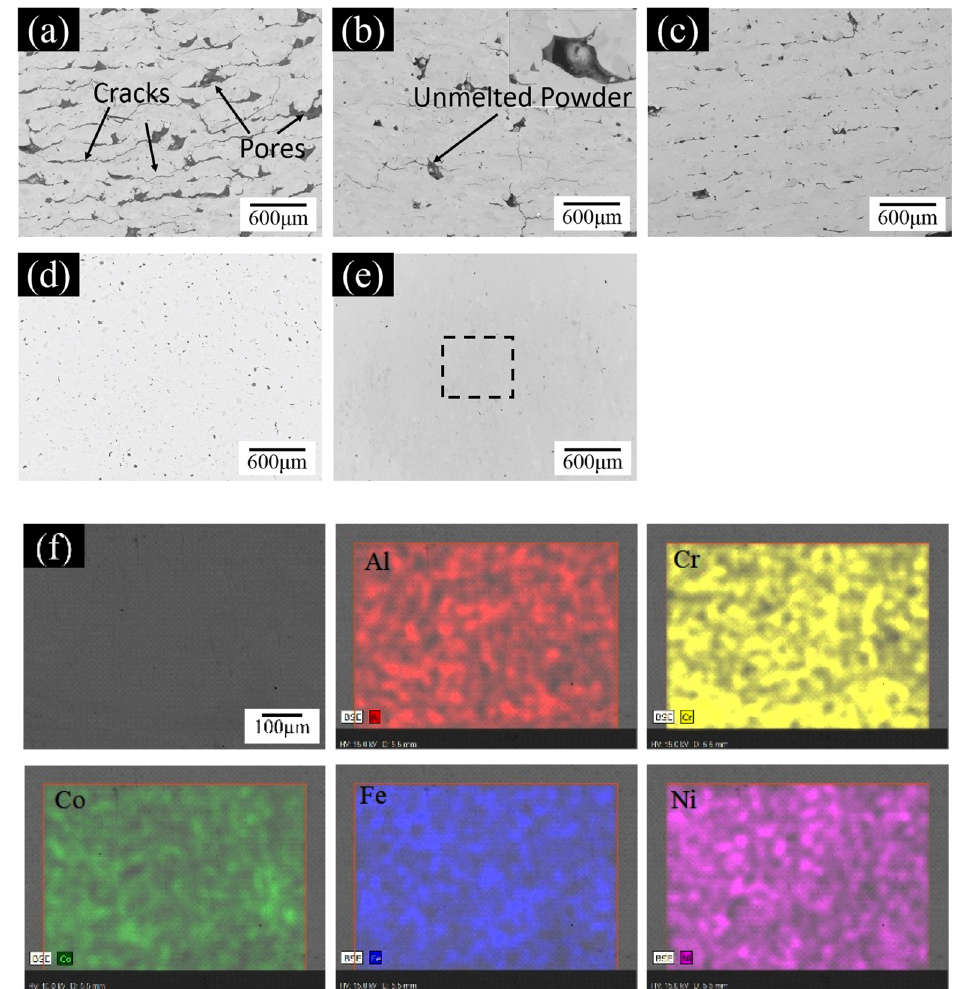
Figure 6. The SEM images of Al 0.5 CoCrFeNi HEAs at different laser power:( a ) 160 W, ( b ) 200 W, ( c ) 240 W, ( d ) 280 W, ( e ) 320 W at a scan speed of 800 mm/s and hatch spacing of 60 μm, and ( f ) image of the selected area illustrated by a square in ( e ) and the elemental distribution maps of the area.